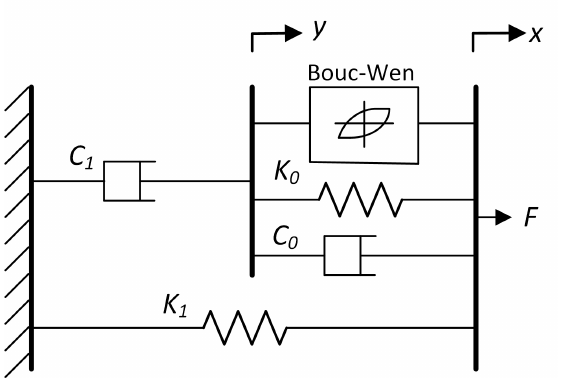
Figure 2. Schematic representation of the modified Bouc–Wen model.